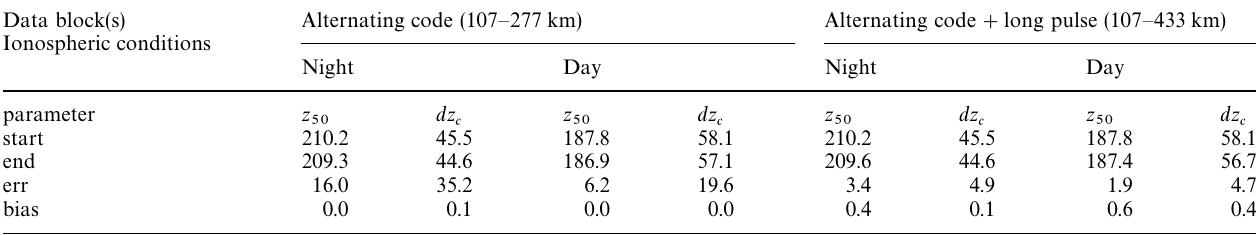
Table 1. Statistical behaviour of the difficult parameter fit Data